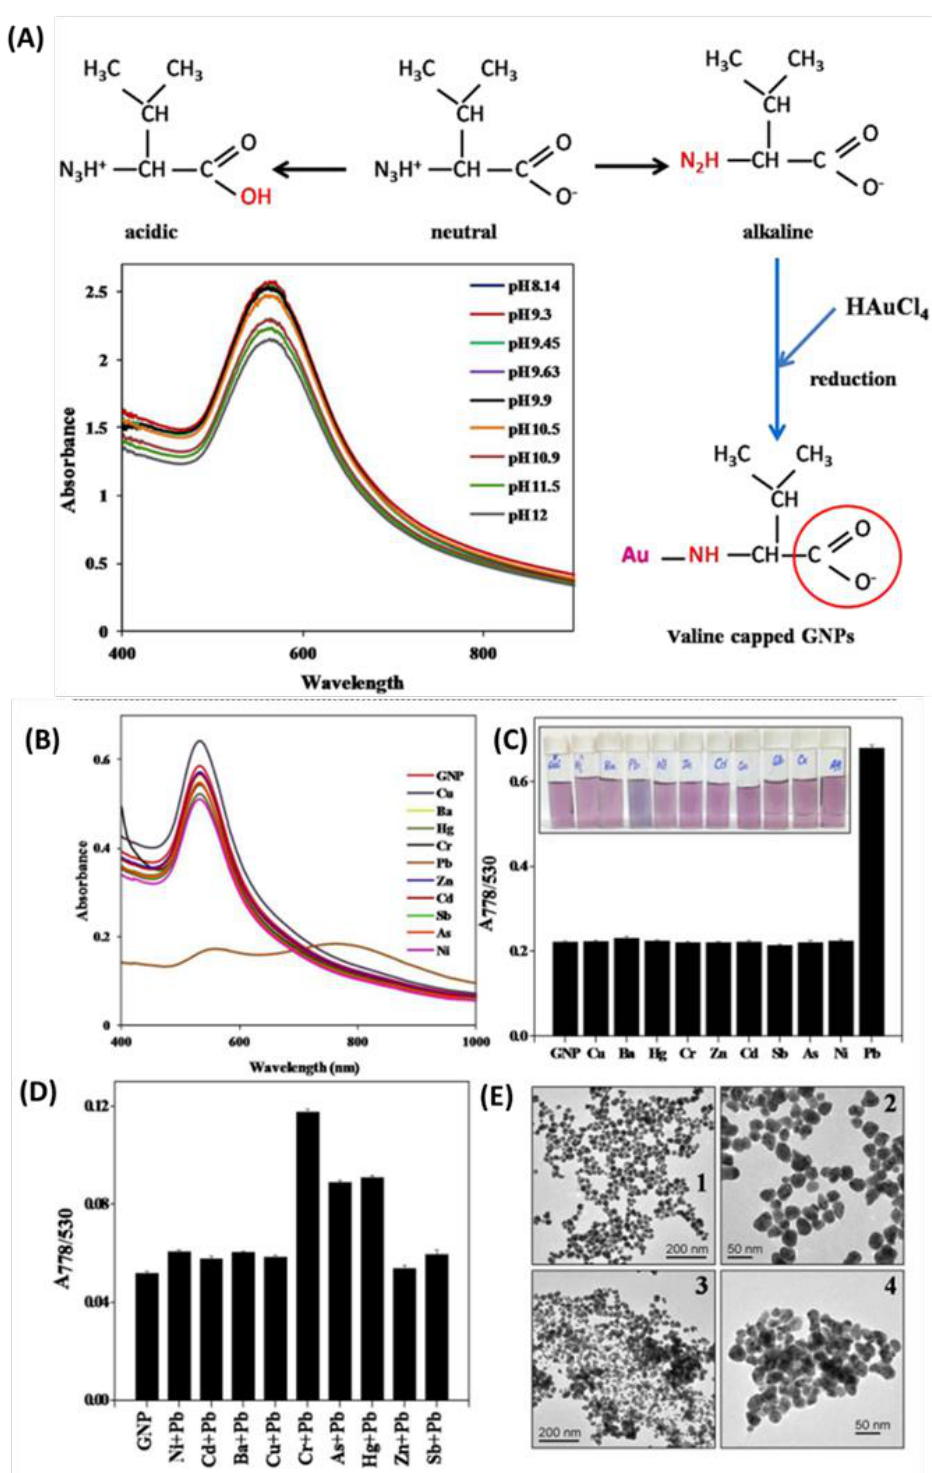
Figure 2. ( A ) Schematic illustration of the mechanism of GNP synthesis and stabilization by valine. Inset shows the effect of high alkalinity of valine capped GNPs. ( B ) Absorption spectra depicting the selectivity of valine-GNPs for Pb 2+ ions. ( C ) Quantitative analysis of selectivity of valine-GNPs. ( D ) Graph showing the absorption ratio obtained by treating valine-GNP with a commixture of 100 ppm of Pb 2+ ion and 100 ppm of respective metal ion. ( E ) TEM images of valine-GNPs ( 1 , 2 ) before treatment with Pb 2+ ions ( 3 , 4 ) after treatment with Pd 2+ ions. Reprinted with permission [116], copyright 2017, Nature